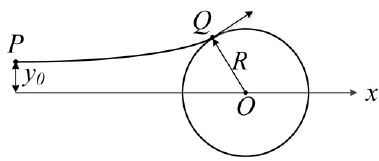
Figure 4. Moving trajectories of the droplet.